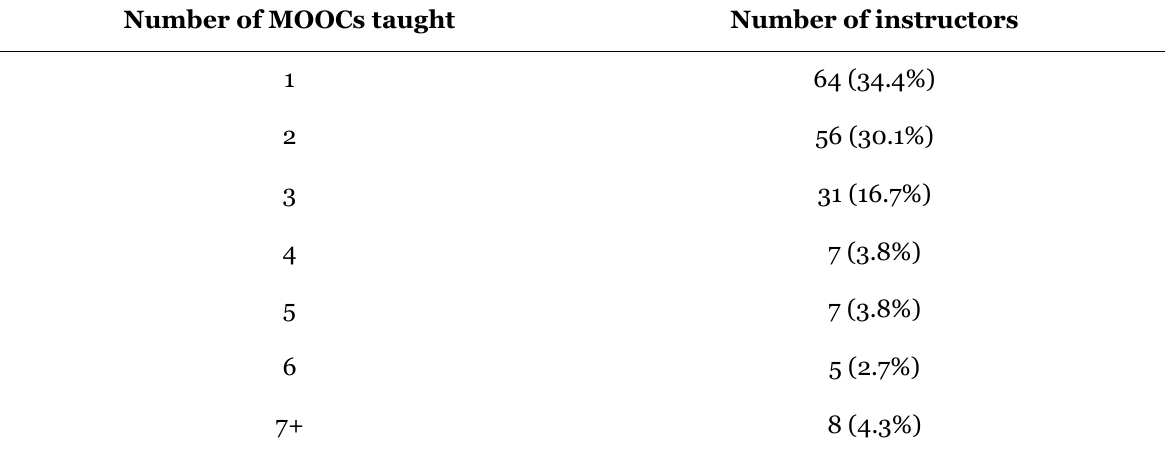
Prior Experience Teaching MOOCs Number of MOOCs taught